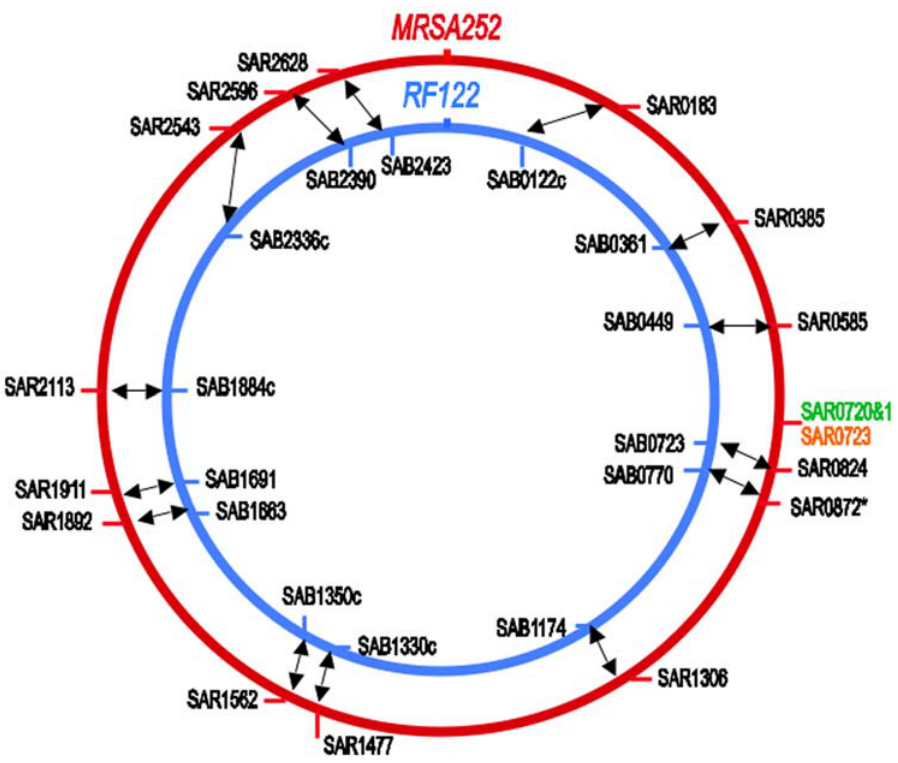
Figure 1. Circular displays of the S.aureus human MRSA252 and bovine RF122 chromosomes showing the relative genomic positions of the uniquely shared DNAs. Shown are the relative positions of the MRSA252 (SAR) and RF122 (SAB) shared genes. The chromosomal position of the MRSA252 - Listeria monocytogenes shared genes copper ATPase and copper oxidase is indicated in green. The chromosome position of the cadmium-transporting ATPase cadA gene shared with the S. saprophyticus pSSP2 plasmid is indicated in orange. Arrows indicate orthologous DNAs.